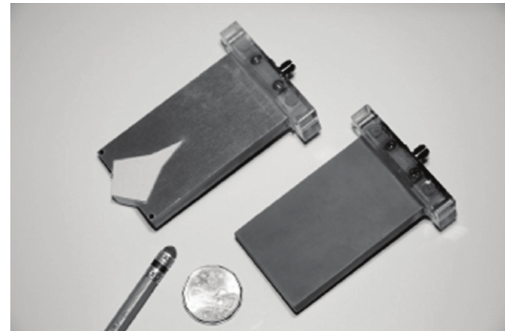
Figure 2: Implemented BAVA-D and BAVA antennas.